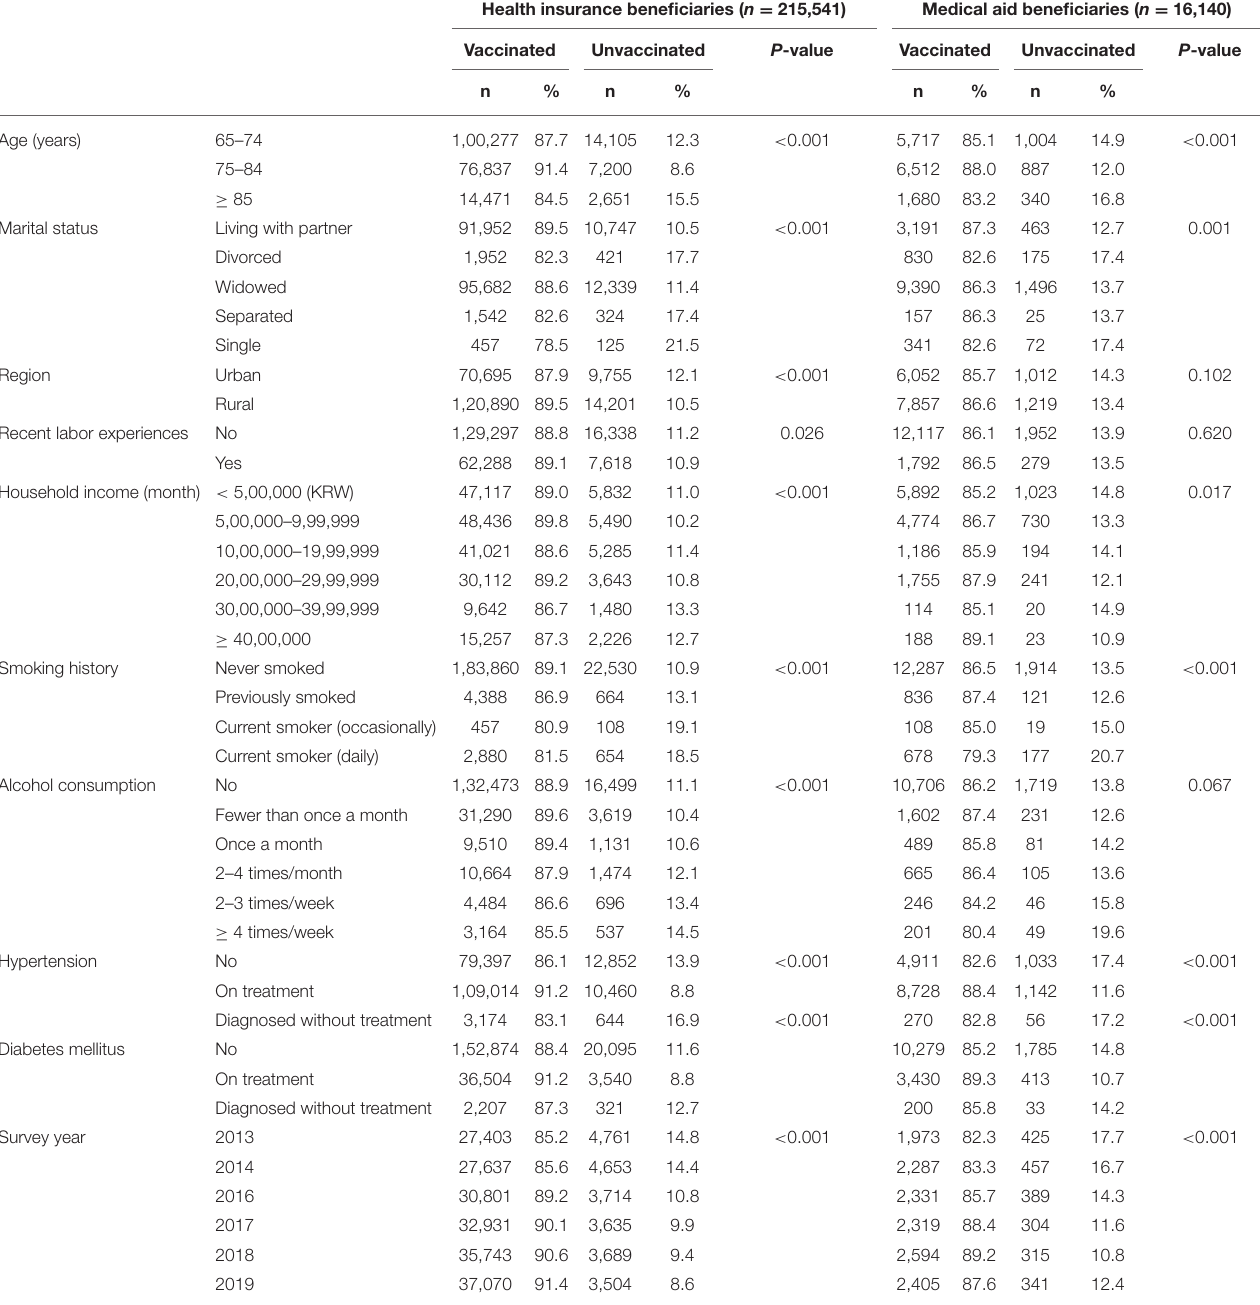
TABLE 1 | Vaccination rates among female participants based on different baseline characteristics stratified by type of health coverage. Health insurance beneficiaries ( n =